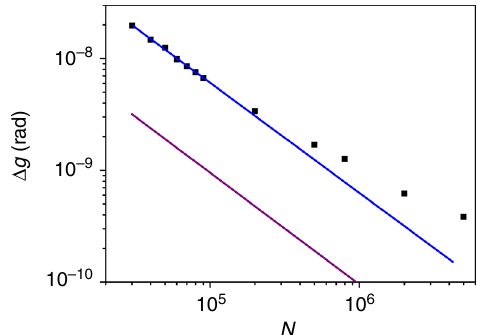
Fig. 4 Experimentally obtained precision showing Heisenberg scaling. By varying the interaction parameter g , via tuning of the temporal overlap of the system and probe, we obtained s ¼ ∂ δ ~ n ∂ (see Supplementary Note 5 for g details). The precision of the estimation procedure is then given by ffiffiffi p Δ g ¼ 2 σ = s ν . We performed this using ε = 0.1, Δ n ’ 0 : 5 N , ν ’ 2 : 2 ´ 10 5 and for a number of values of N from 3 × 10 4 to 5 × 10 6 . For N < 10 5 the precision follows an HS, of Δ g ’ 6 : 3 ´ 10 (cid:3) 4 N (cid:3) 1 rad, shown as a blue line, obtained by fi tting these points. In this regime s has a linear dependency on ffiffiffi p ν N , while the uncertainty σ = is roughly independent of N . For higher values of N , there is a deviation from the HS, due to the non-linearity of s . The purple line is a bound on the precision for mixed states, taking account the QFI for each member in the ensemble, given by Δ